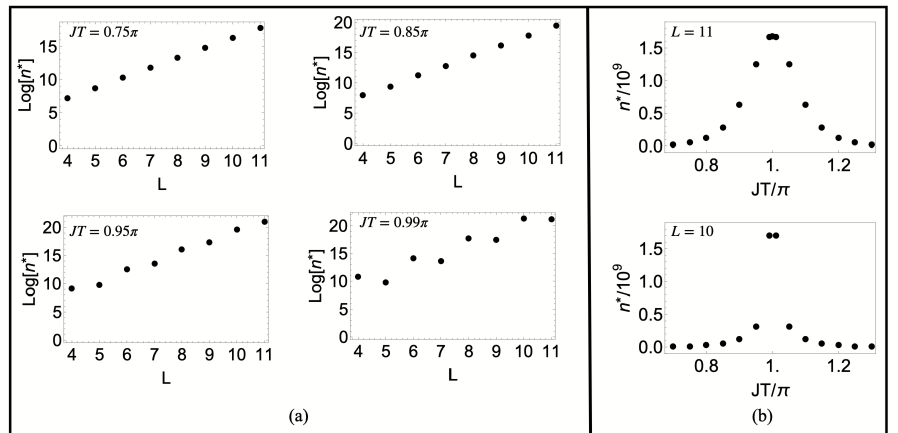
Figure 5. ( a ) The dependence of the DTC lifetime, n ∗ defined below Equation (3) on the system size for various values of JT . We find that the lifetime increases exponentially with the system size. When JT ≈ π , the spin chain exhibits an interesting feature: the lifetime of an even size system of length L is almost the same as that of an odd size system of length L + 1. This is due to a constructive interference from several paths for even size chains. ( b ) The dependence of the lifetime on JT for a fixed spin chain length, L . It is evident that n ∗ is maximum, when JT = π for both even and odd size chains.